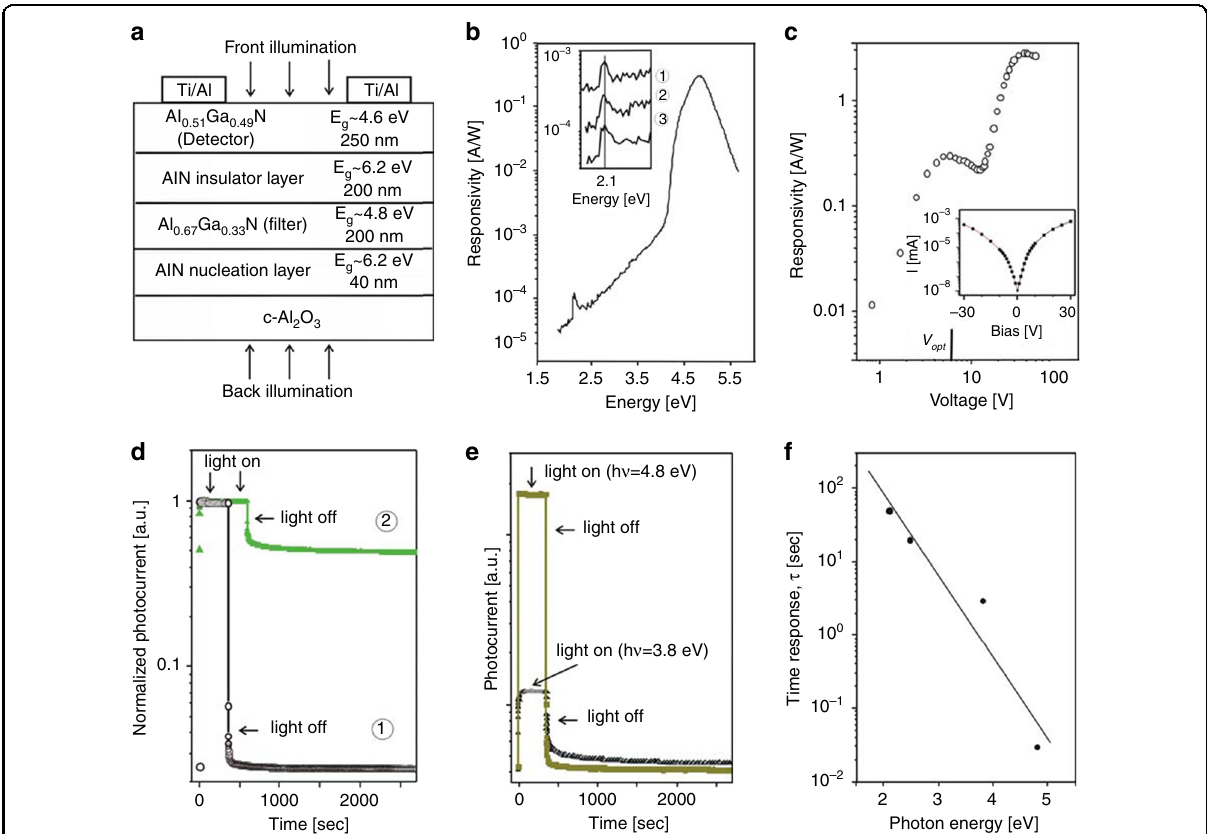
Fig. 9 Structure and performance of an AlGaN solar-blind photoconductor. a Schematic structure of AlGaN photodetector. b Spectral responsivity of the AlGaN detector at back-illumination under 5 V bias. The insert illustrates the photocurrent resonance peak, measured at 5 V (curve 1), 12 V (curve 2), and 15 V (curve 3), respectively. c Spectral responsivity versus applied voltage ( h ν ~ 4.8 eV). The inset presents the dark current. V opt is the trap-free point (6 V). d Time response ( h ν ~ 4.8 eV) at 5 V (dark circles) and 15 V (green triangles). e Time response at 5 V (trap-free regime) with 4.8 eV photon (squares) and 3.8 eV photon (triangles). f Time constant versus photon energy at 5 V. Reprinted with permission from Cherkashinin et al. 55 . Copyright 2006 WILEY-VCH Verlag GmbH & Co. KGaA,